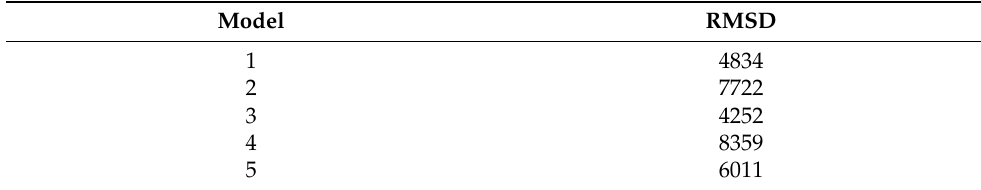
Table 1. RMSD values associated with the five models obtained with PEP-FOLD.